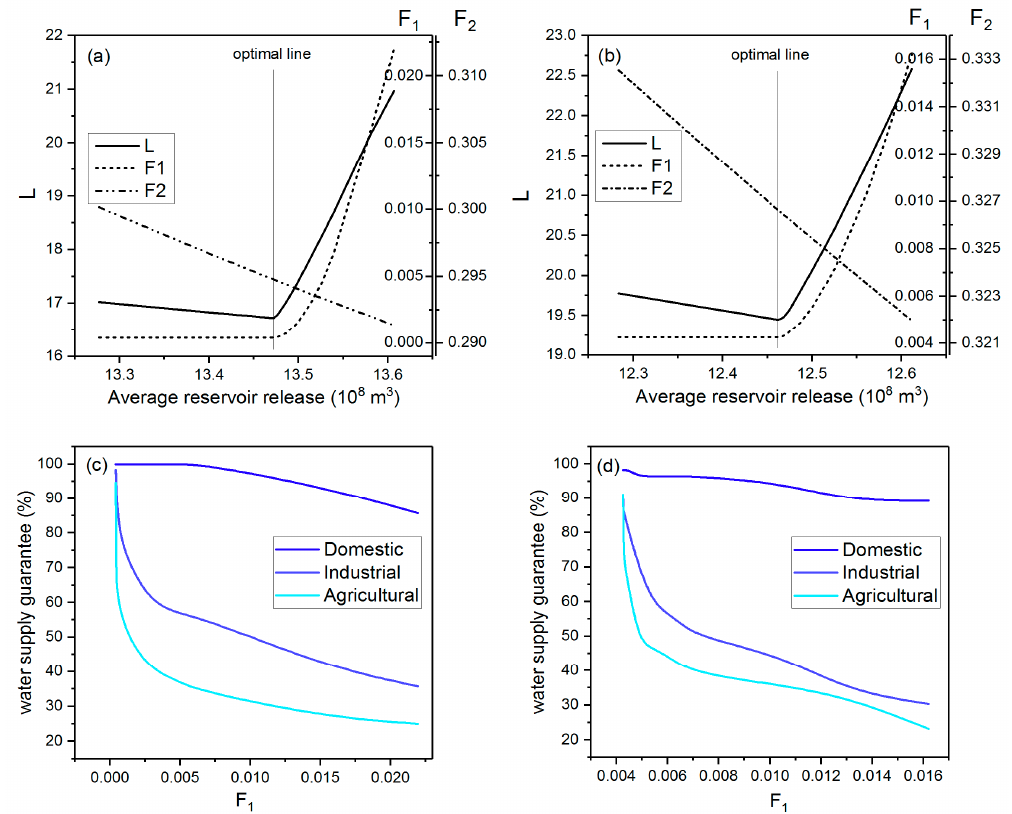
Figure 8. Sensitivity analysis of parameters: ( a , c ) 2020; ( b , d ) 2030.